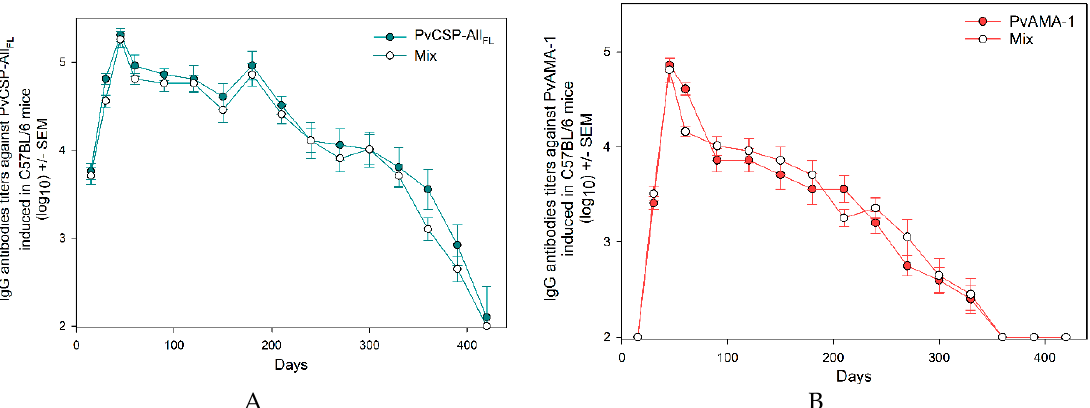
Figure 4. IgG antibodies longevity analysis. The IgG antibody longevity induced in C57BL / 6 mice was monitored for 420 days after the first vaccine dose by ELISA against PvCSP-All FL ( A ) and PvAMA-1 ( B ). The results are expressed as the arithmetic mean titers of each group in log 10 ± SEM.